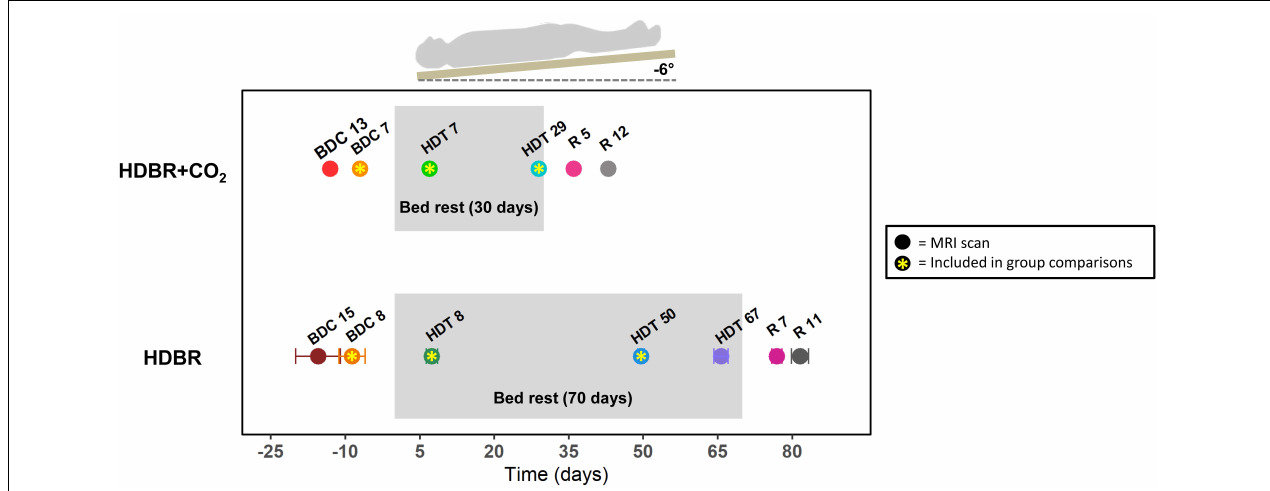
FIGURE 1 | Testing timeline. Top: testing timeline for the HDBR + CO 2 group, who completed 30 days of head-down-tilt bed rest (HDBR) with 0.5% elevated atmospheric CO 2 . Bottom: testing timeline for the HDBR group, who completed 70 days of HDBR with normal atmospheric CO 2 levels. BDC, baseline data collection; HDT, head-down-tilt bed rest; R, recovery. Circles indicate the day for each MRI scan. Circles with asterisks represent the three time points used to create intercept and slope images for between-group comparisons. All HDBR + CO 2 subjects completed MRI scans on exactly the same days with respect to bed rest. There was some variability in testing days for the HDBR group; average day is plotted, with error bars indicating standard deviation. Mobility and balance data were collected at all time points for the HDBR + CO 2 group, with the exception of HDT 7 and HDT 29 (i.e., participants did not complete standing tasks during bed rest). One additional mobility and balance data collection took place on R0 for the HDBR + CO 2 group within ∼ 3 h of first standing up. Mobility and balance scores at BDC 7 and R 0 were used for brain-behavior correlations with MRI data from BDC 7 and HDT